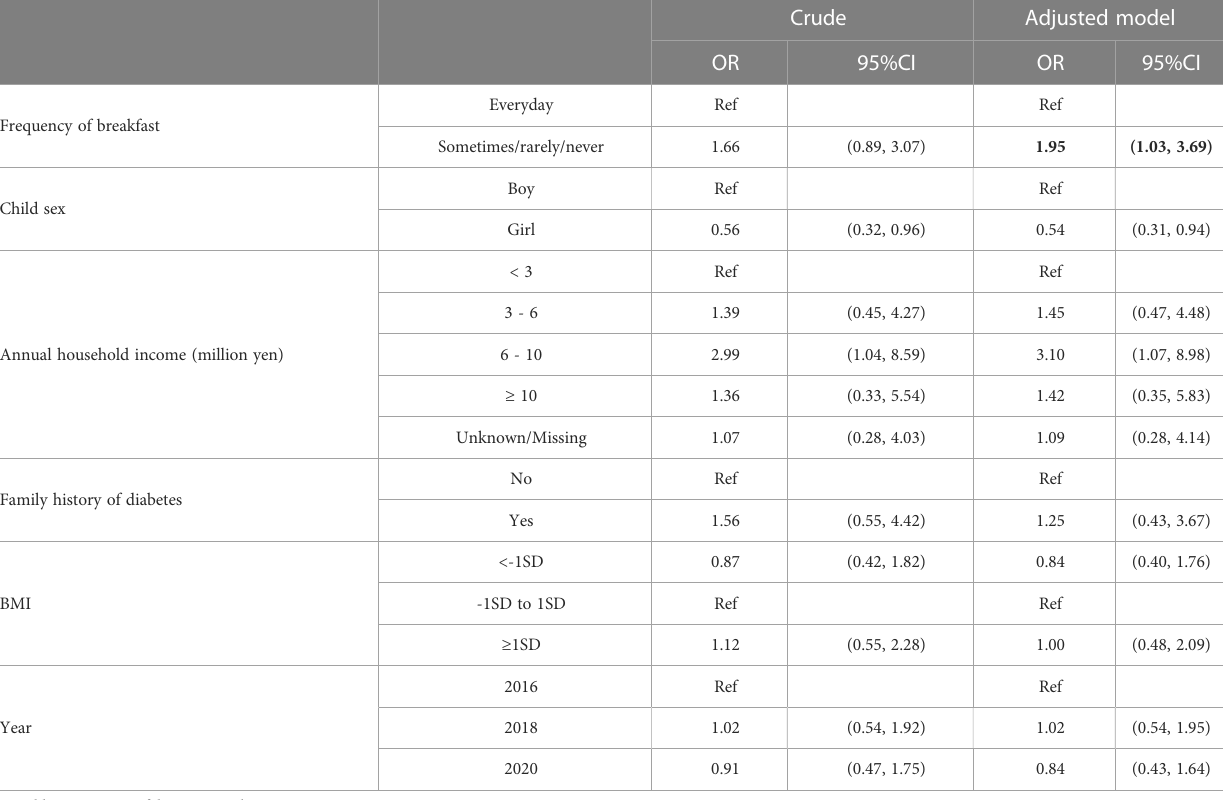
TABLE 2 Odds ratio for prediabetes and skipping breakfast (n=1510).